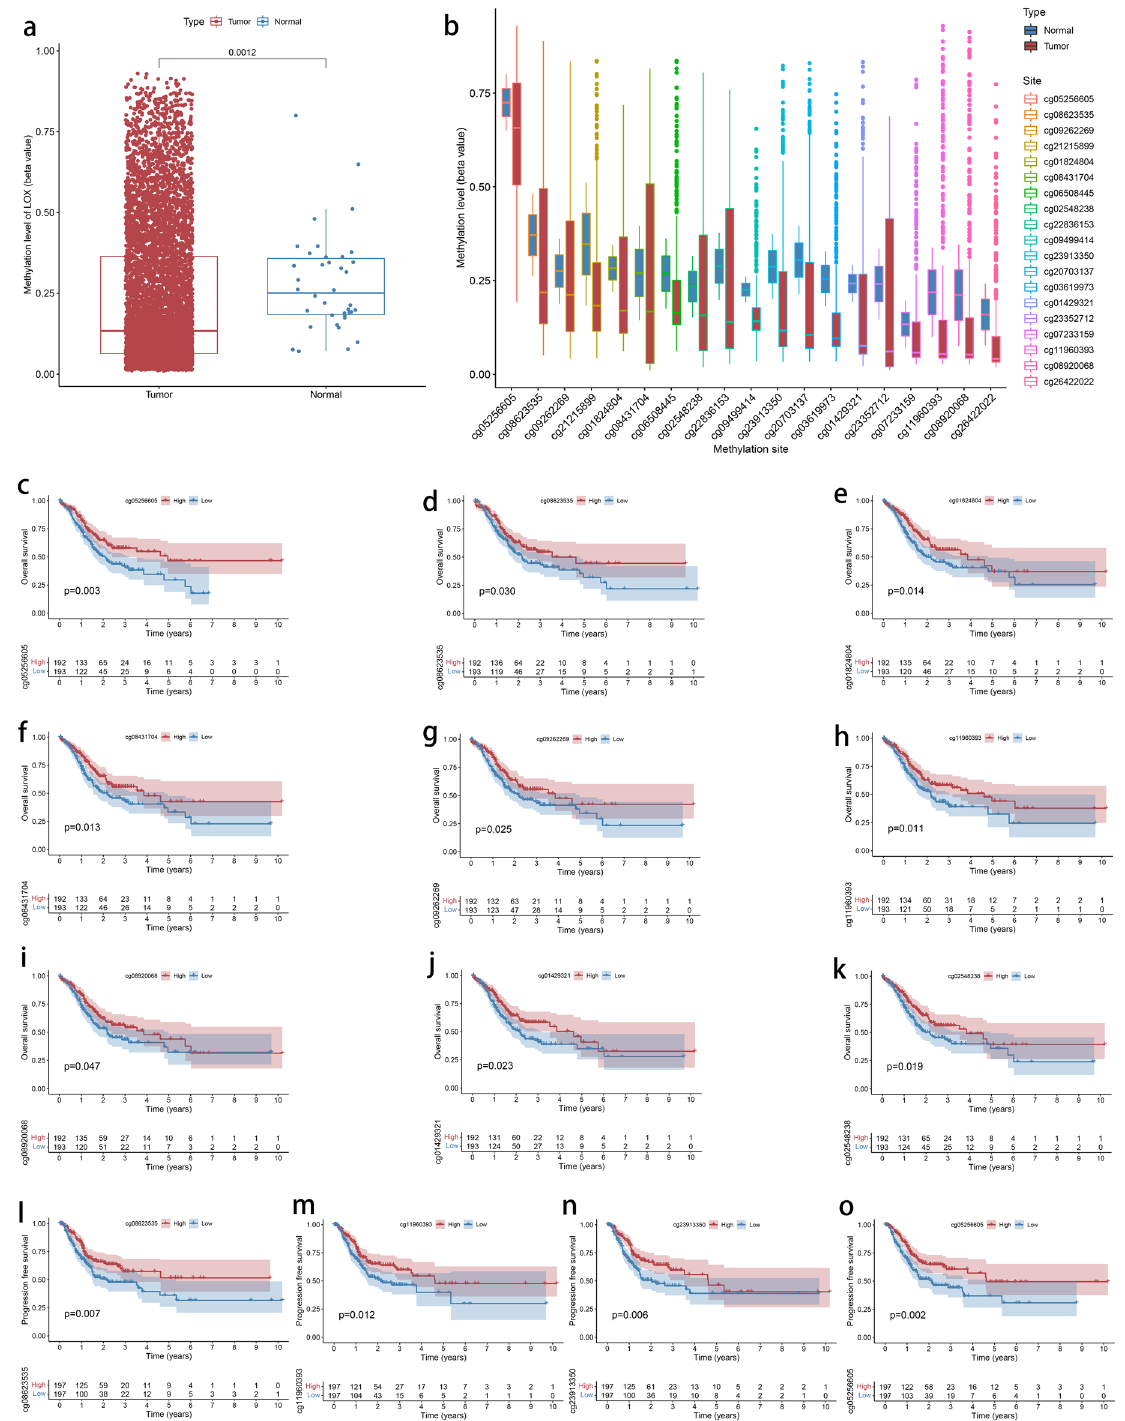
Figure 7. The association of LOX gene methylation and expression with clinicopathologic parameters. ( a ): The LOX gene methylation was expressed at a significantly lower level in GC tissues than in normal. ( b ): The distribution of LOX DNA promoter CpG sites. The low methylation levels of cg sites (cg05256605, cg08623535, cg01824804, cg08431704, cg09262269, cg08920068, cg01429321, cg02548238, and cg11960393) of LOX were related to an unfavorable OS ( c , d , e , f , g , h , i , j , and k ). The low methylation levels of cg sites (cg08623535, cg11960393, cg23913350, and cg05256605) of LOX were related to an unfavorable PFS ( l , m , n and o